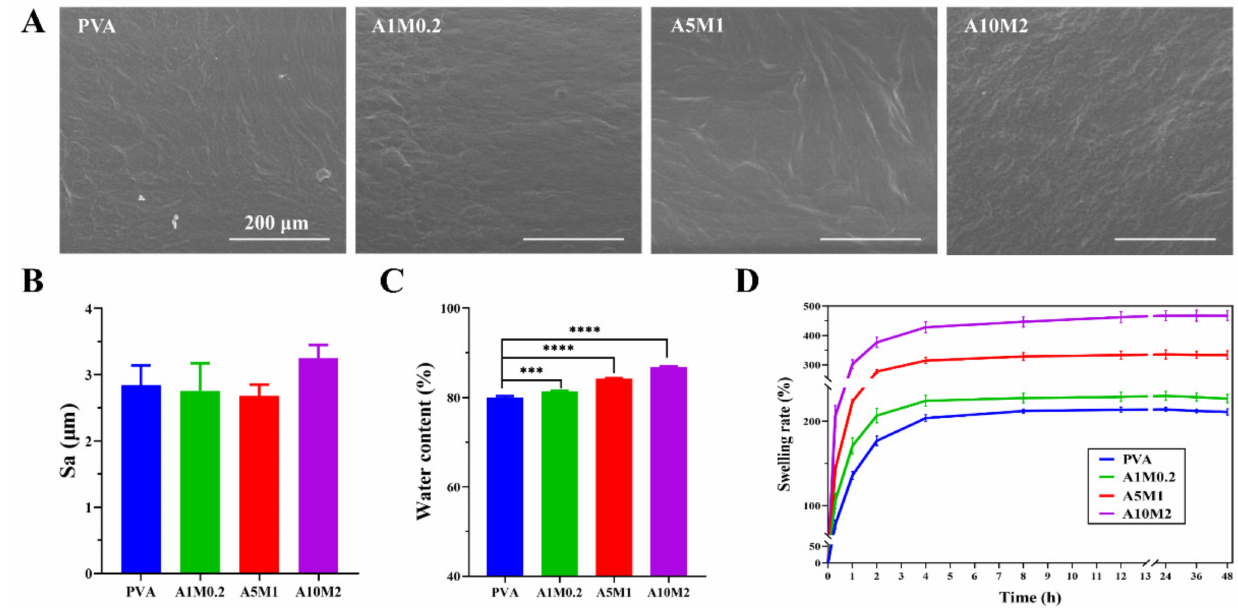
Figure 2. Physicochemical properties of the HPX/PVA hydrogels. ( A ) ESEM images of surface morphology of the PVA and HPX/PVA hydrogels; scale bar: 200 µ m. ( B ) The surface roughness of PVA and HPX/PVA hydrogels. ( C ) Water content of PVA and HPX/PVA hydrogels. ( D ) Swelling ratio of PVA and HPX/PVA hydrogels. The error bars indicate the mean ± standard deviations from three independent experiments. Statistical analysis was performed using ordinary one-way analysis of variance (ANOVA) with Dunnett’s multiple comparisons (*** p < 0.001, **** p <